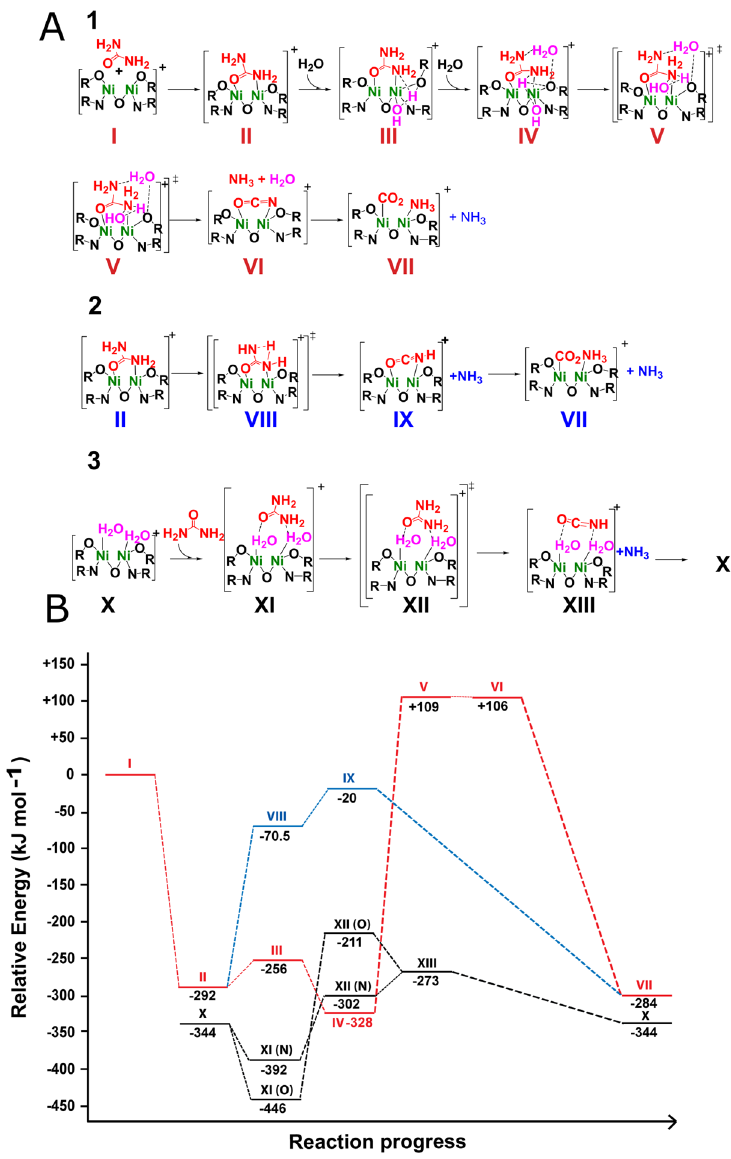
Figure 7. Three possible mechanism pathways ( A ) and their corresponding reaction energy diagrams: (1) urea coordination followed by water coordination to promote the elimination mechanism forming isocyanate, which is further hydrolyzed into carbon dioxide and ammonia. (2) Urea-coordinated self-elimination mechanism. (3) Water coordination followed by urea interaction, through oxygen or nitrogen to undergo an elimination mechanism forming isocyanate. ( B ) Theoretical energies calculated for the several reaction pathways.